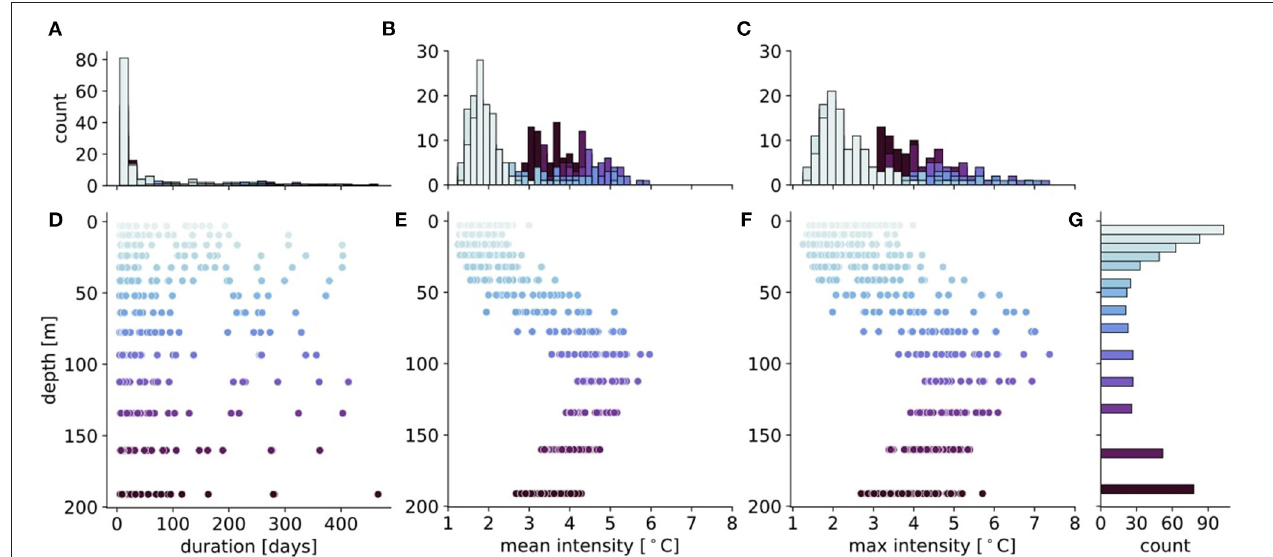
FIGURE 7 | MHW metrics with depth; distribution of MHW duration (D) , mean intensity (E) and maximum intensity (F) with depth for each detected MHW during 1960–2019, averaged across the shelf (ecoboxes, see Figure 1 ); (A–C) show the distribution for each metric in the color for each depth as in (D–F) ; (G) shows the total count of MHWs for each